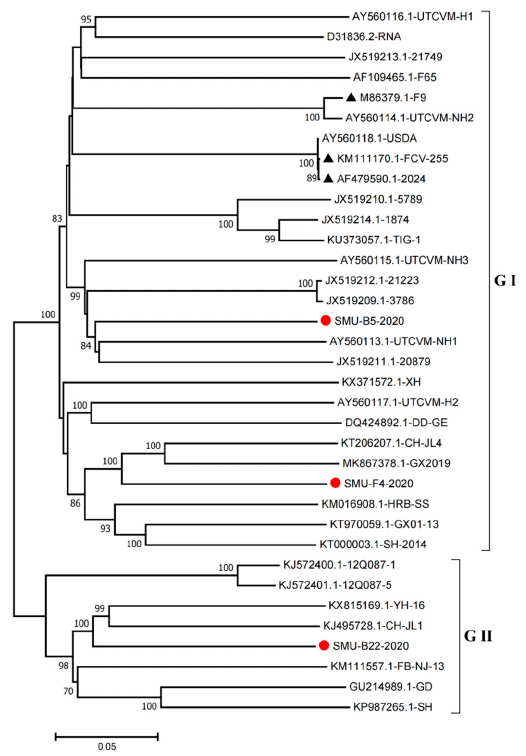
Figure 4. Phylogenetic tree based on full-length genomic sequence of three isolates (SMU-B22-2020, SMU-F4-2020, and SMU-B5-2020) and FCV reference strains available in GenBank. The three isolates in this study are labeled with “red circles” and the vaccine strains are labeled with “black triangles”. The scale bar indicates the number of nucleotide substitutions per site. To identify possible recombinant events, we detected recombination using SimPlot and RDP4 software packages. The SMU-B5-2020 strain showed potential recombinant events between the FCV-21223 strain (cluster I of GI) and the HRB-SS strain (cluster III of GI) with p -values of <1 × 10 − 6 from the results of five detection methods. From the similar- ity plot, two recombination breakpoints within the SMU-B5-2020 genome were identified in ORF1 (nt 3104) and ORF2 (nt 5328) (Figure 5a). The breakpoints in SMU-B5-2020 sepa- rated its genome into three regions, with regions A (nt 1–3104) and C (nt 5328–7705) being closely related to the FCV-21223 strain, whereas region B (nt 3104–5328) was closely re- lated to the HRB-SS strain (Figure 5b). The results indicated that the SMU-B5-2020 strain likely originated from recombination events between members of clusters I and III of the GI FCV strains.